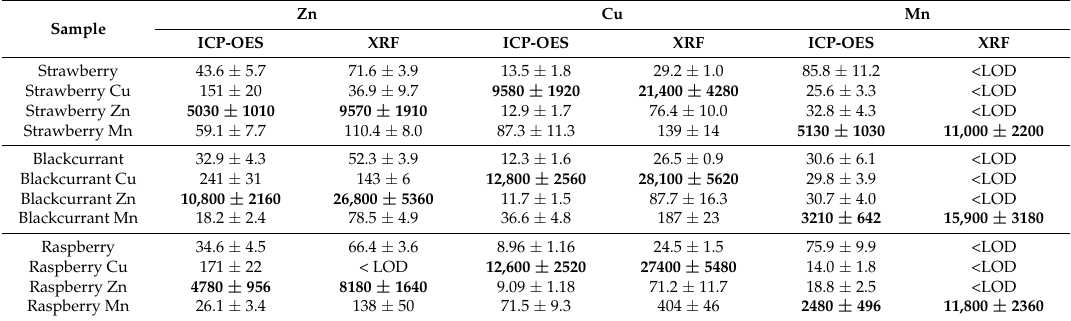
Table 2. Zn, Cu and Mn content of post-extraction berries seeds residues determined by ICP–OES and XRF (mg/kg).